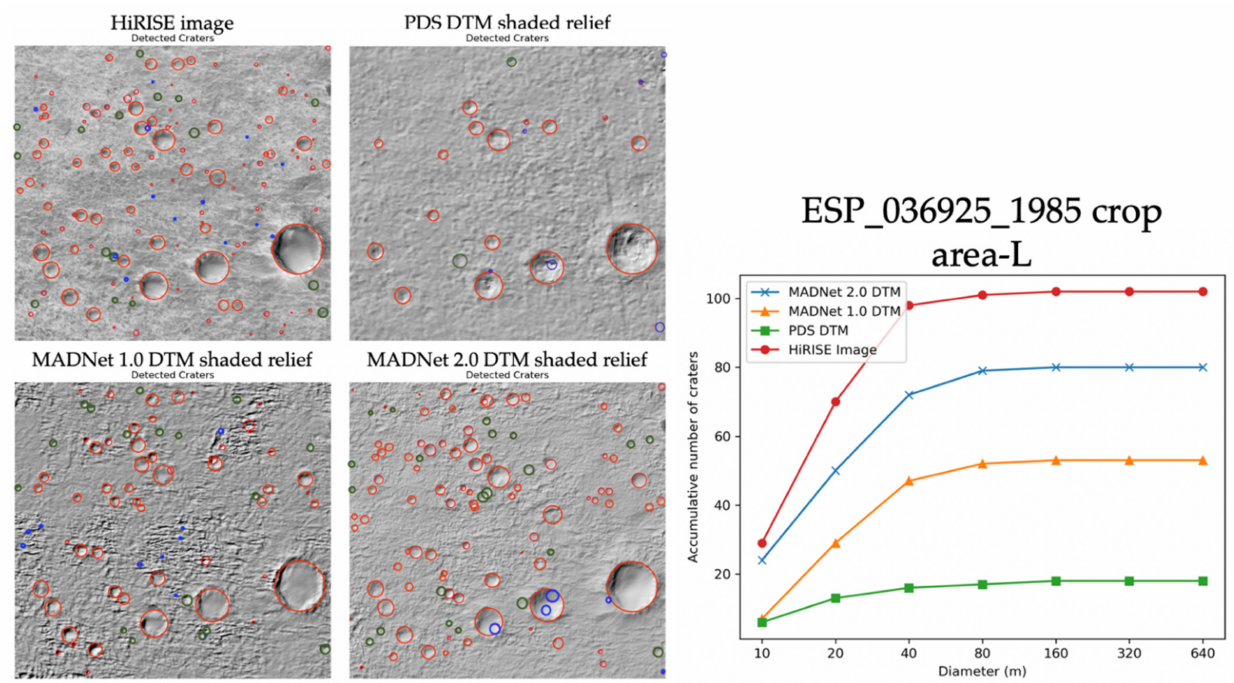
Figure 17. Crater detection and size-number counting from HiRISE image and the hill-shaded relief images of the PDS DTM, MADNet 1.0 DTM, and MADNet 2.0 DTM, over a 500 m × 500 m cropped area (area-L of ESP_036925_1985_RED). N.B. automatically detected craters are in red circles; manually excluded false-positives are in blue circles; manually added true-positives are in green